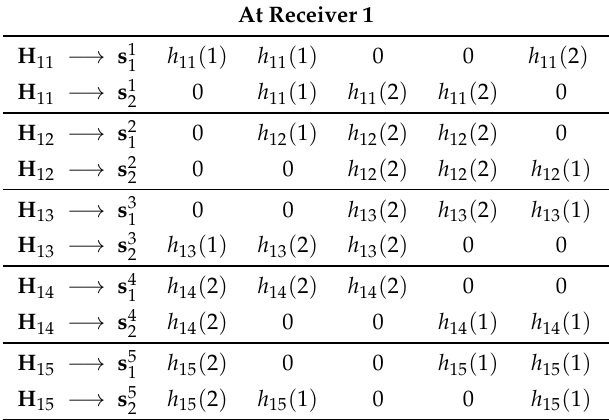
Table 1. Antenna switching pattern for receiver 1.